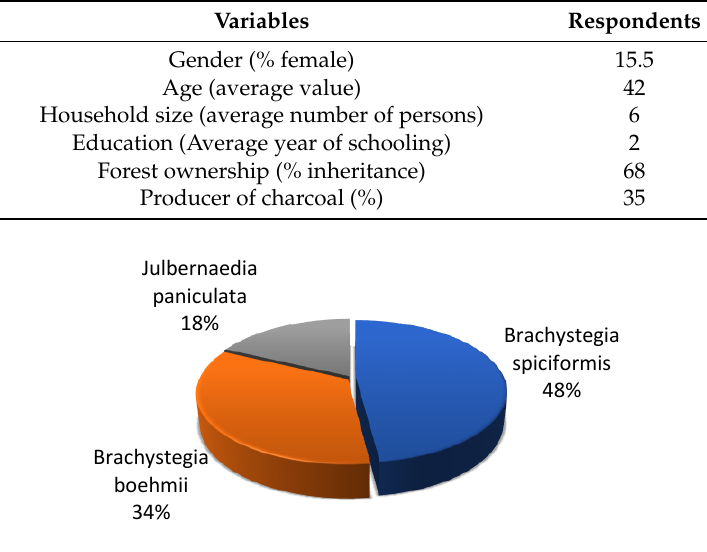
Figure 3. Preferred species for charcoal production.